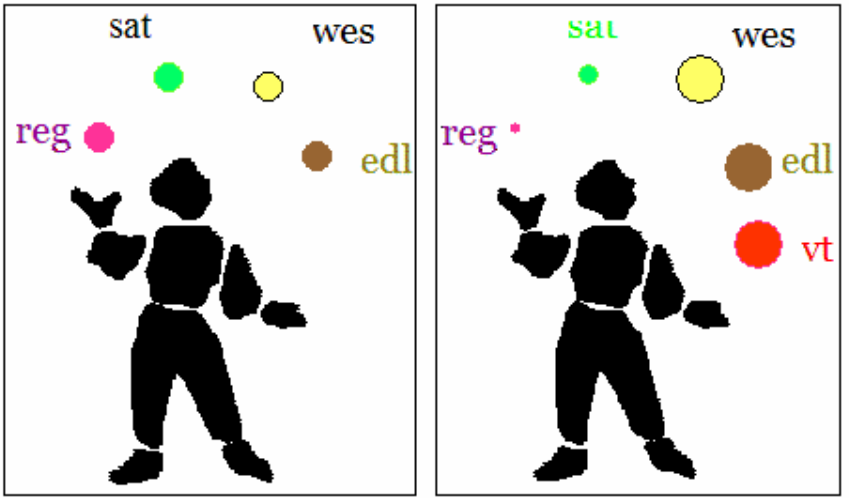
Figure 2 . The “Juggling Game” with various tutorial events